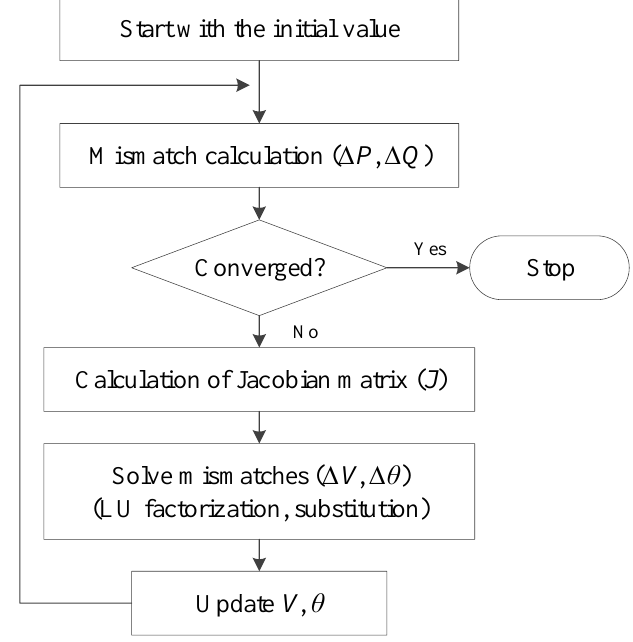
Figure 2. Brief algorithm of the Newton–Raphson (NR)